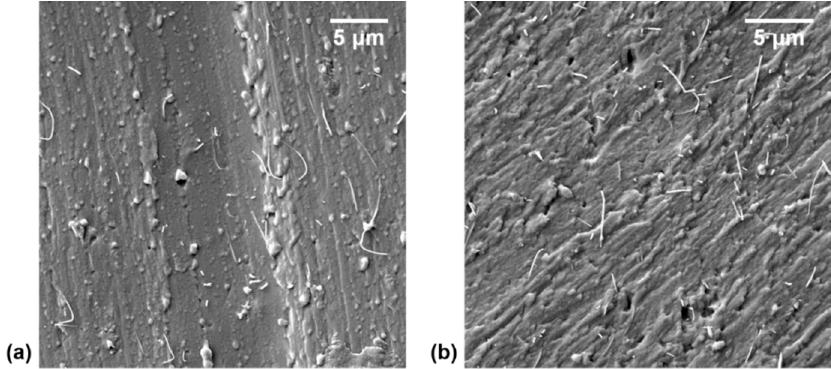
Figure 2. Scanning electron microscope (SEM) images of CNT dispersion within ( a ) 1 wt.% and ( b ) 2.5 wt.% m-PDMS/CNT.